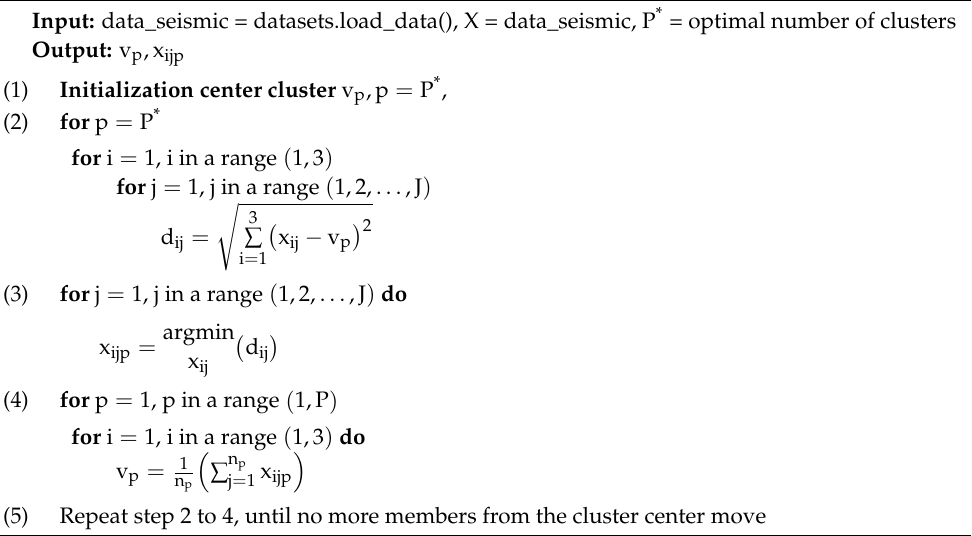
Algorithm 2. Pseudo code of K-Means Algorithm